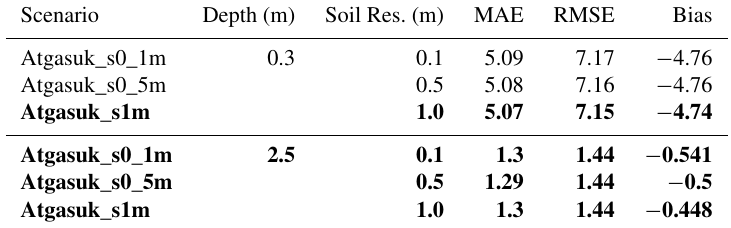
Table E1. Atqasuk modeled water temperature errors calculated from measured water temperature time series at 0.3 and 2.5m across different soil vertical resolution simulations. Bold rows are the lowest RMSE for a given water depth. The following variables are included: mean absolute error (MAE), root-mean-square error (RMSE), and mean average error (bias) Scenario Depth (m) Soil Res. (m) MAE RMSE